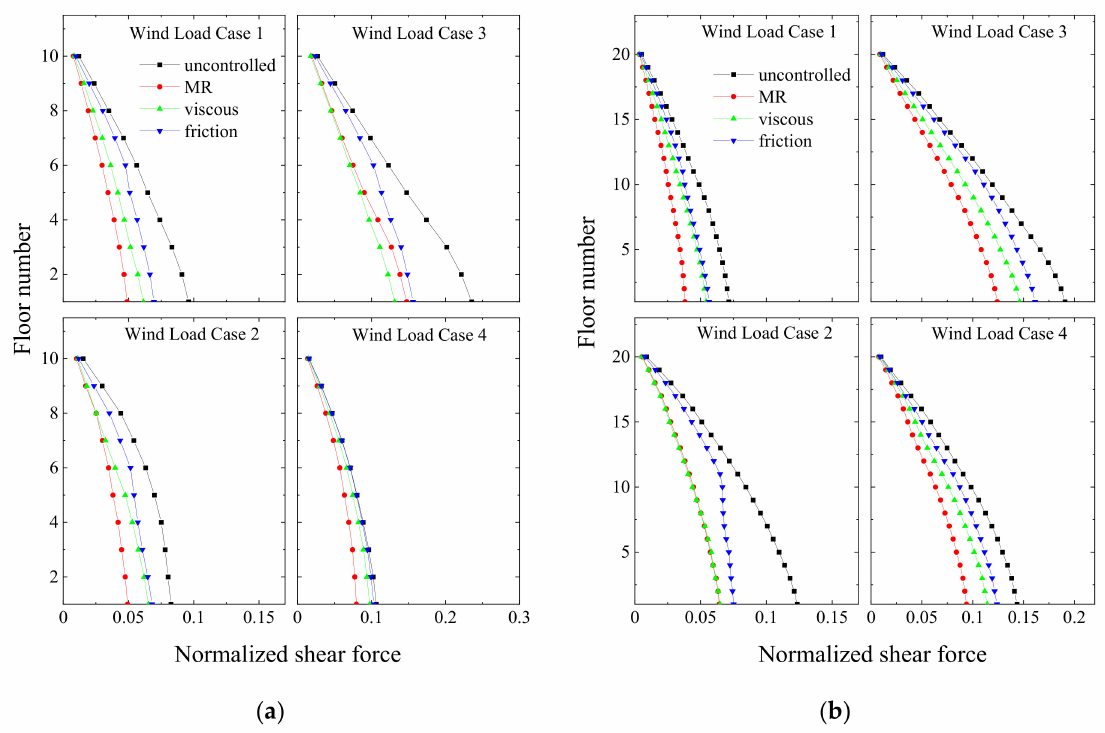
Figure 34. Peak normalized floor shear force response under wind excitation obtained from different dampers in: ( a ) a coupled stiff building and ( b ) a coupled flexible building when dampers are arranged in Configuration